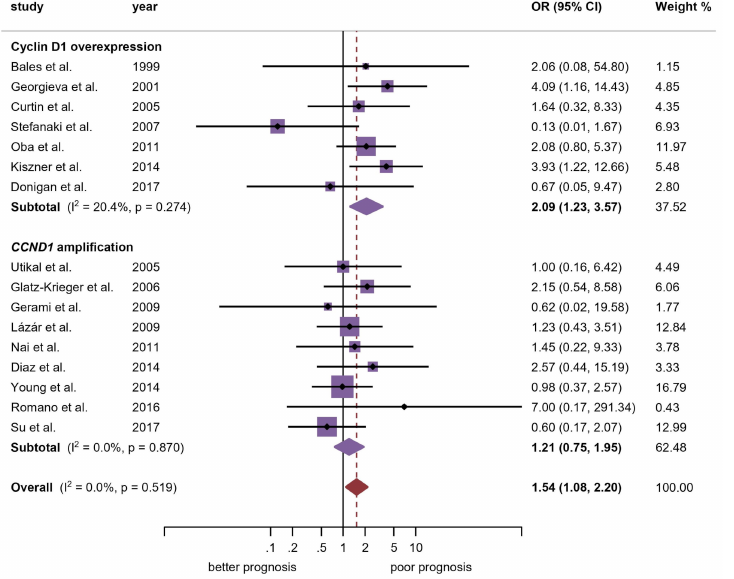
Figure 3. Forest plot graphically representing the association between CCND1 /cyclin D1 alterations and Breslow thickness in cutaneous melanomas. OR, odds ratio; CI, confidence intervals. Fixed-effect model (Mantel–Haenszel method) pooling odds ratios (the references cited in this figure are listed in Supplementary